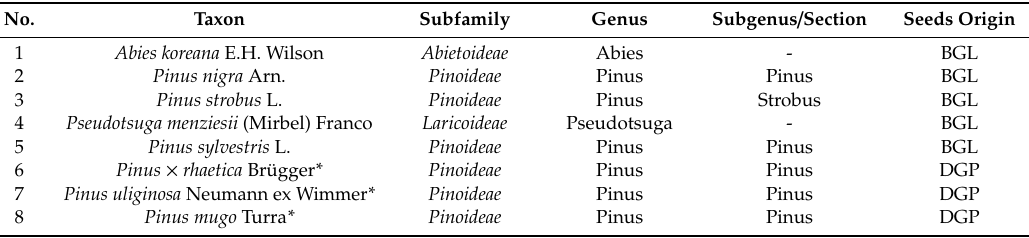
Table 3. The Pinaceae taxa investigated in the present study. The seeds origin: BGL—The Botanical Garden in Lodz (Poland); DGP—The Dendrological Garden, Poznan University of Life Sciences (Poland). * taxa belonging to the Pinus mugo